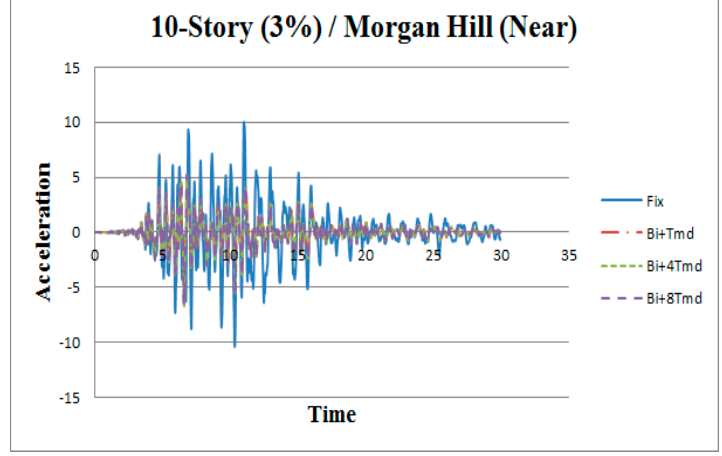
Figure 7. Acceleration time histories for top story of 10-story building under the Morgan Hill (near-fault) earthquake.